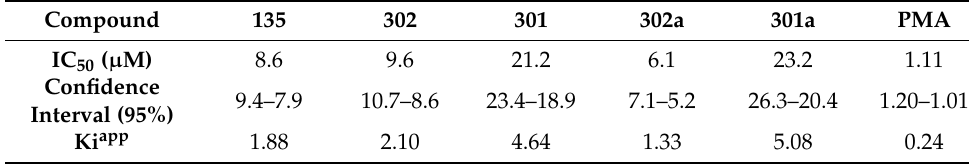
Table 3. Results for VS-selected diterpenes as inhibitors of Lm PTR1.